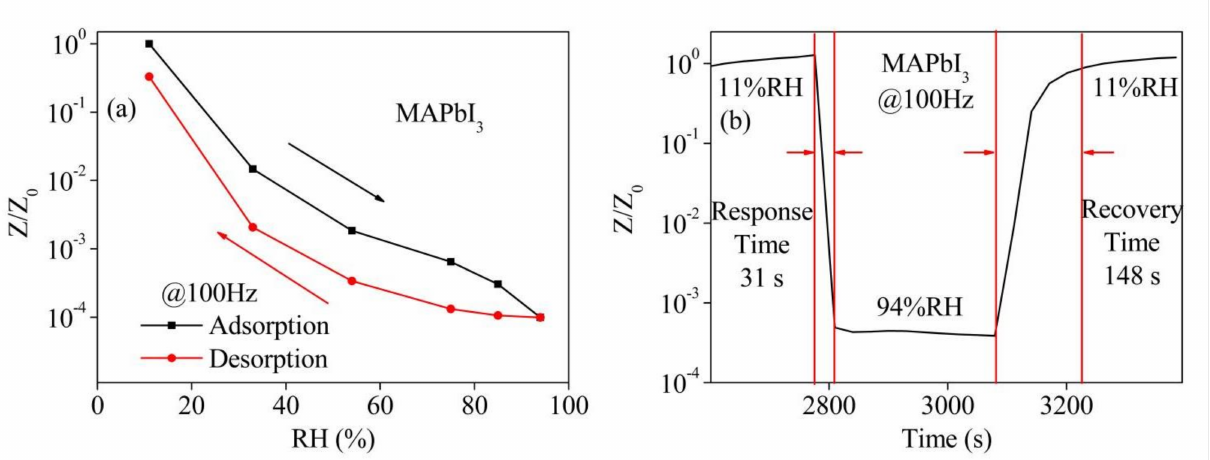
Figure 6. ( a ) Hysteresis behavior and ( b ) recovery/response time of the MAPbI 3 -based sensor ( Z / Z 0 is the normalized impedance to the initial impedance Z 0 ). Table 1. Hysteresis and response/recovery time under different RH levels of the MAPbI 3 -based sensor. Hysteresis Response Time (s) Recovery Time (s)